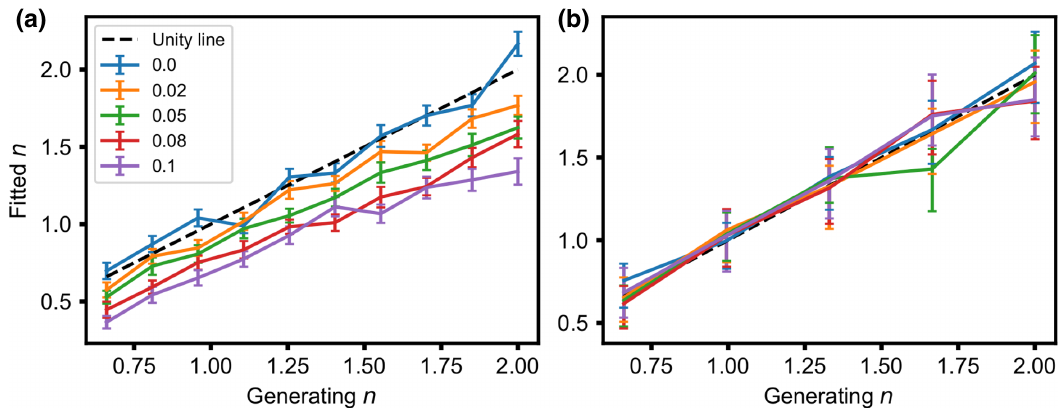
FIG. 18. Recovery of actual stretching factors. (a) When an offset term is included in the fit, the true stretching factor is not fully recovered when fitting the DEER echo divided by the coherence when the offset is large. (b) Simultaneously fitting the coherence and DEER signals using MCMC, the correct stretching factor is